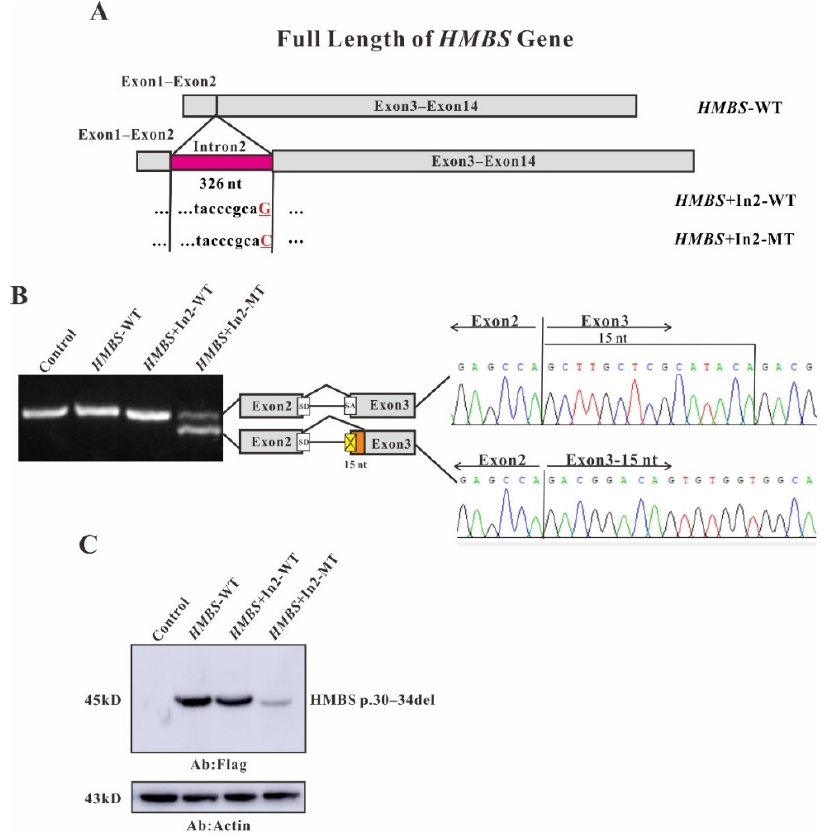
Figure 3. Full length with intron 2 of HMBS gene constructs for splicing pattern investigation. ( A ) Schematic representation of the HMBS gene with intron 2 construct. The nucleotide sequences of the HMBS +In2-WT and HMBS +In2-MT are shown below. The changed nucleotide in intro 2 of both wildtype and mutant HMBS full gene are labeled by red and underscore. ( B ) Gene splicing assay. HMBS -WT, HMBS +In2-WT and HMBS +In2-MT were transiently transfected into HEK293T cells. After RNA isolation the splicing products were analyzed by RT-PCR. The higher bands represent correct splicing, whereas the lower band represents the HMBS missing 15 nt in exon 3. ( C ) Western blot analysis for the expression of HMBS -WT, HMBS +In2-WT and HMBS +In2-MT. Whole cell lysates were separated by SDS–PAGE (12% acrylamide). Flag monoclonal antibodies were used.